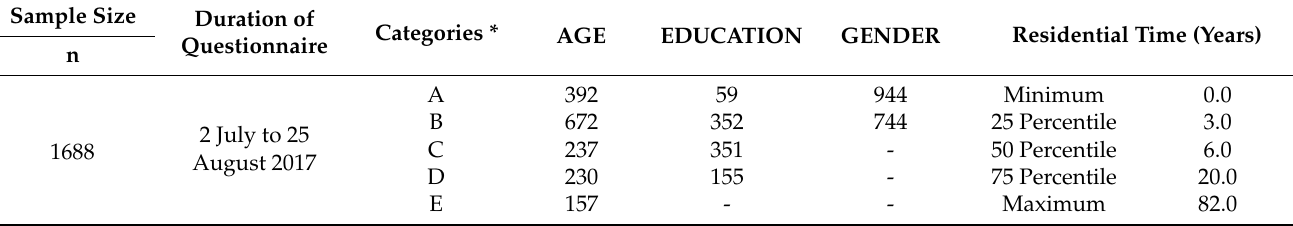
Table A1. General information regarding data collection and